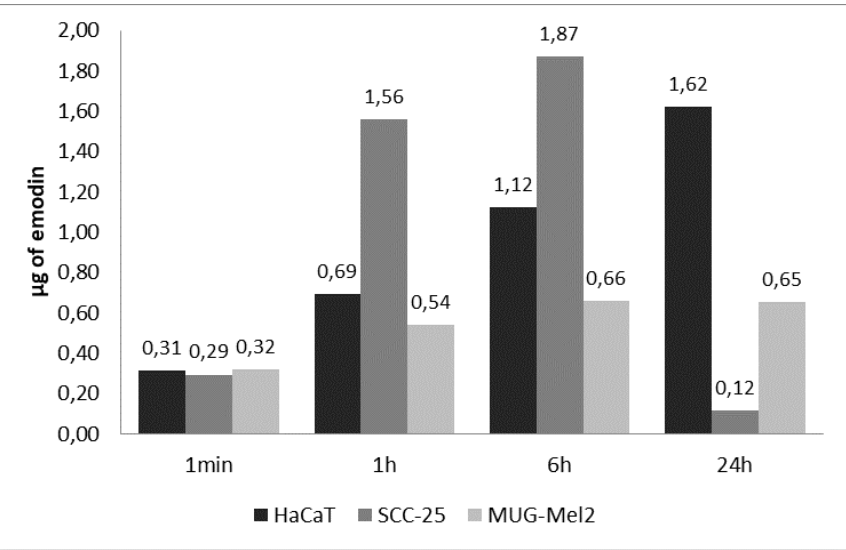
Figure 7. Emodin extracted from different cell lines treated with 30 µM emodin in growth medium.